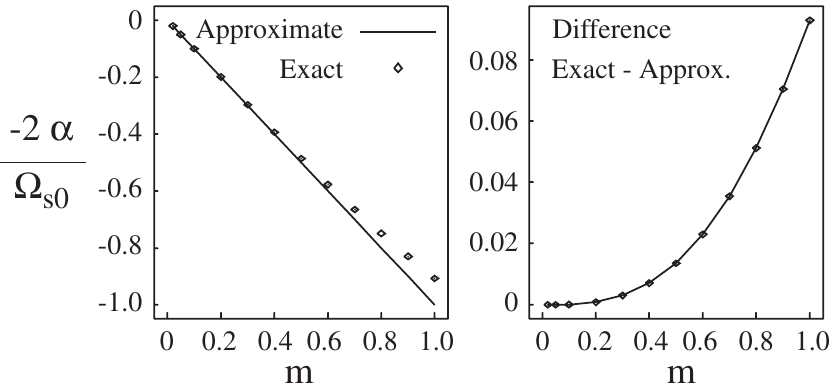
FIG. 3. Results of linear fits determining effective bunch length decay rate (cid:3)